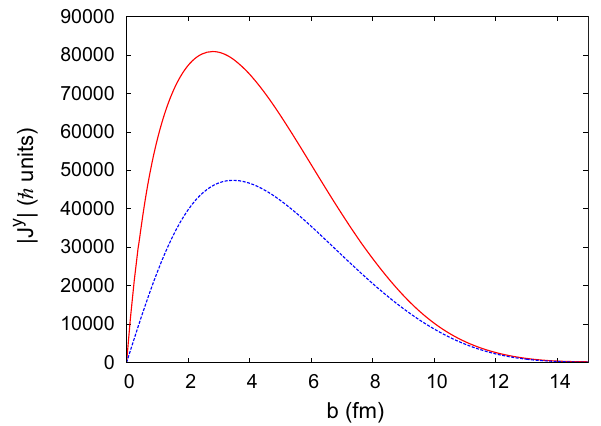
Fig. 12 Mean values of thermal vorticity components at the freeze-out as a function of η/ s . Note that the (cid:6) x η ,(cid:6) y η ,(cid:6) τη have been multiplied by 1 /τ